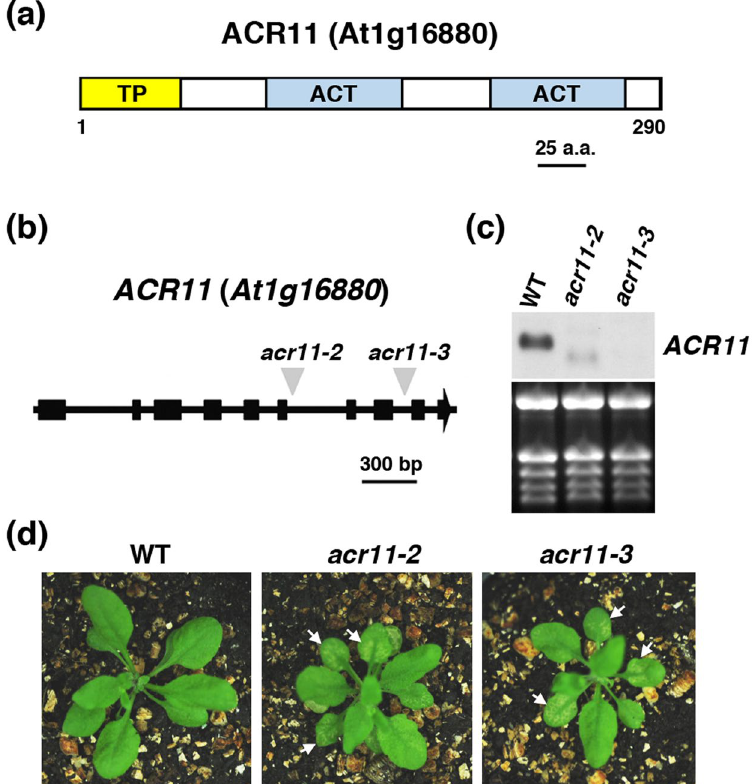
Figure 1. Molecular and phenotypic analyses of Arabidopsis acr11 mutants. ( a ) Schematic diagram of the Arabidopsis ACR11 protein. TP, transit peptide. ( b ) Schematic diagram of the ACR11 gene and the locations of T-DNA insertion in the acr11-2 and acr11-3 mutants. ( c ) RNA gel-blot analysis. Total RNA extracted from 2-week-old wild type (WT), acr11-2 and acr11-3 seedlings was used to detect the expression of ACR11 . The full-length blot is shown in Supplementary Fig. S5. ( d ) Four-week-old Arabidopsis WT, acr11-2 and acr11-3 mutant plants grown in soil under normal conditions. Lesions appear in the rosette leaves of the acr11 mutants are indicated by white arrows.